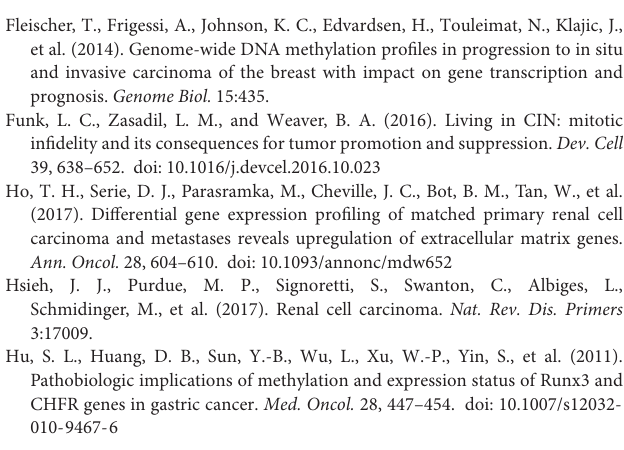
Supplementary Figure 1 | Pan-cancer mRNA expression of CHFR. (A) Boxplots show CHFR expression in tumor (red) and normal (blue) tissue samples in different types of cancer. ∗ p < 0.05, ∗∗ p < 0.01, ∗∗∗ p < 0.001. (B–D) PRAD, LIHC, and KIRC patients with high CHFR expression had a worse OS rate than those with low CHFR expression. Supplementary Figure 2 | Identification of CHFR overexpression in kidney tumor tissues vs. normal tissues from different Oncomine datasets. Supplementary Figure 3 | Cox regression analysis of 23 methylation